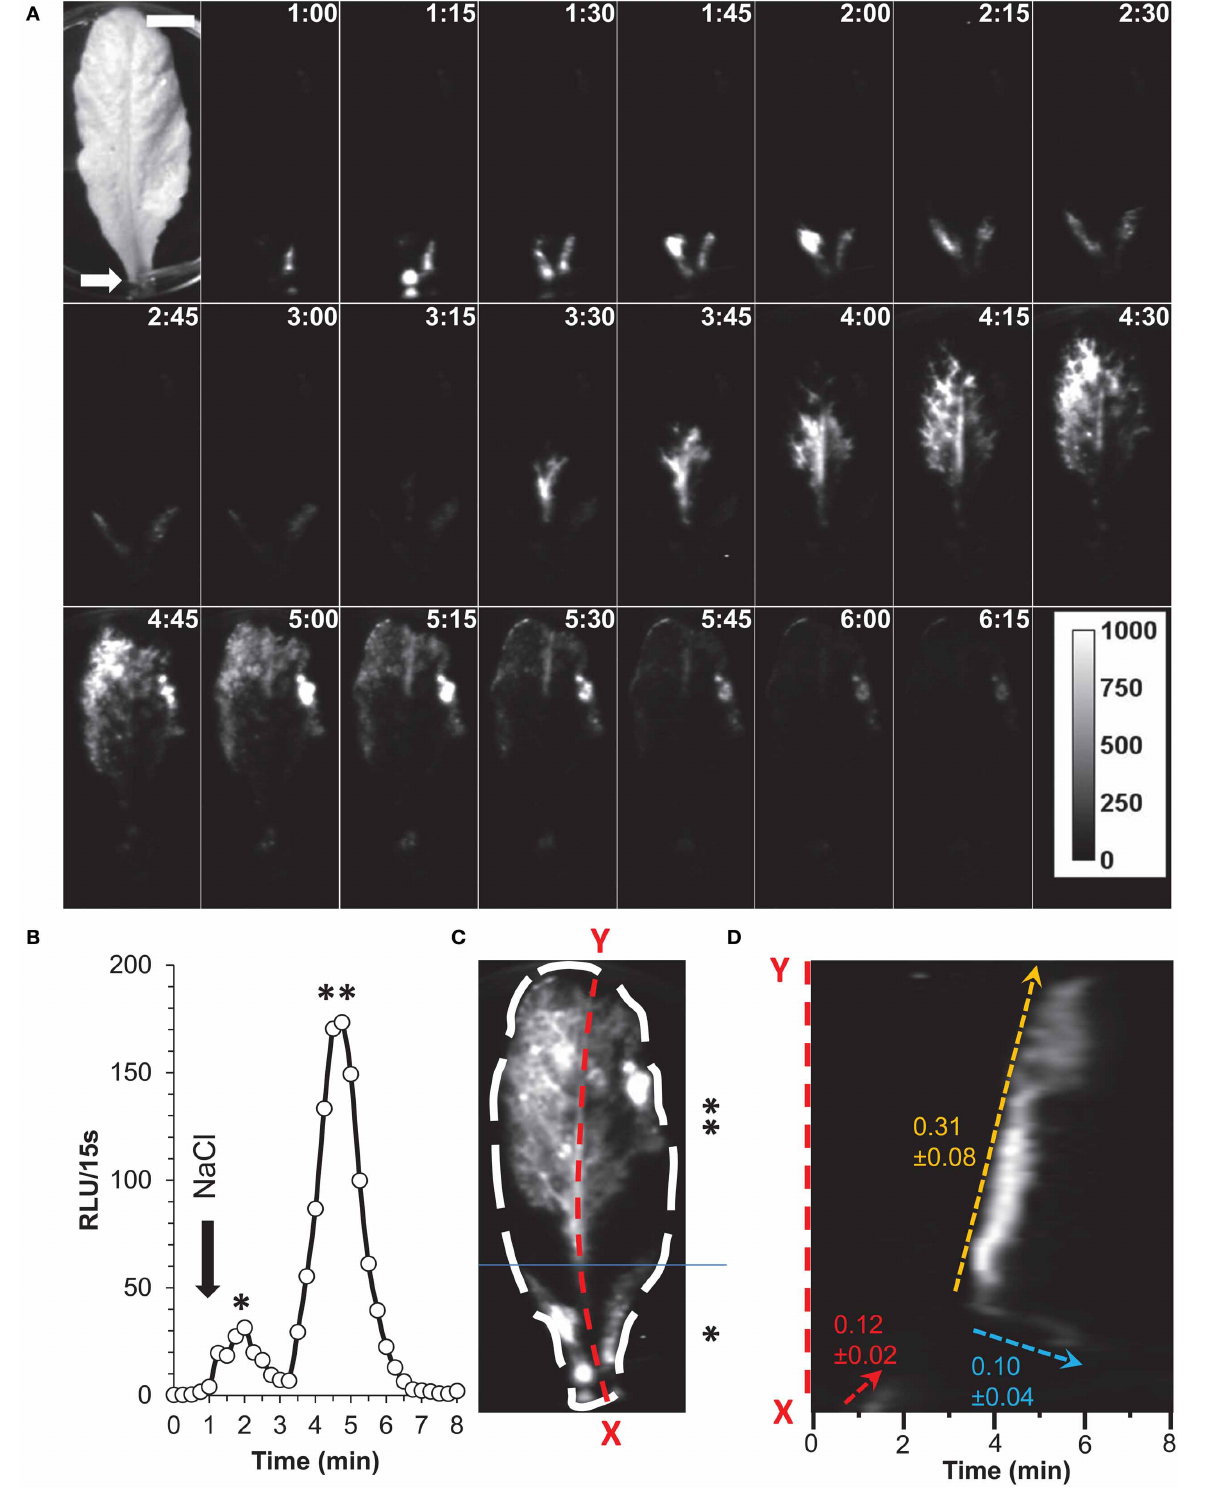
the plant. At time = 1min, 100 μ L of a solution of NaCl (200mM) was dispensed onto the petiole (white arrow) and light subsequently emitted from leaves was integrated over 7min (each image shows cumulative light over